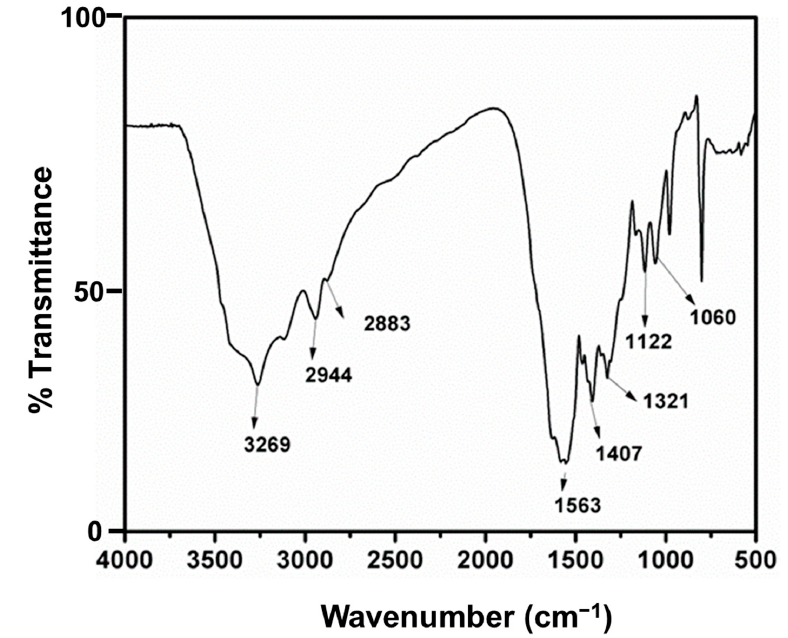
Figure 1. FTIR spectrum of ETPMP.